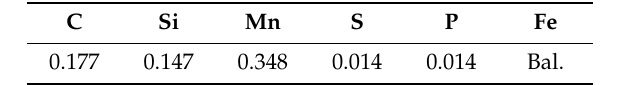
Table 2. Chemical composition of Q235B low-carbon steel (wt.%).